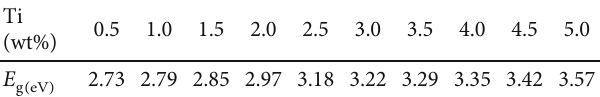
2.73 2.79 2.85 2.97 3.18 3.22 3.29 3.35 3.42